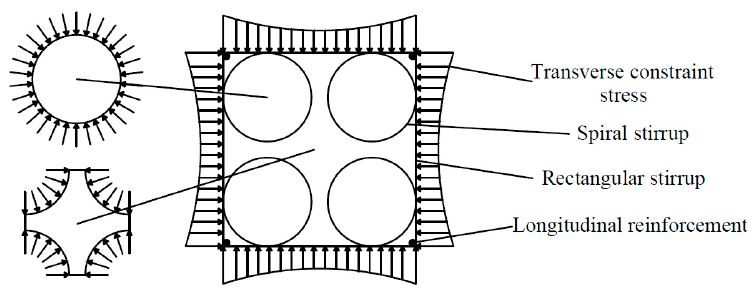
Figure 7. Distribution of transverse constraint stress of square column with four spiral stirrups. According to the different degrees of constraint, the cross-section of the square column is divided into three parts: highly constrained region, partially constrained region, and unconstrained region, as shown in Figure 8. The highly constrained region is the area surrounded by four inner spiral hoops. The concrete in this area is constrained by both the outer rectangular hoop and inner spiral hoops. The partially constrained region is the area outside the circular spiral stirrup and inside the rectangular stirrup. The concrete in this area is constrained by the outer rectangular hoop and four concrete cylinders. The unconstrained region is the concrete protective layer.